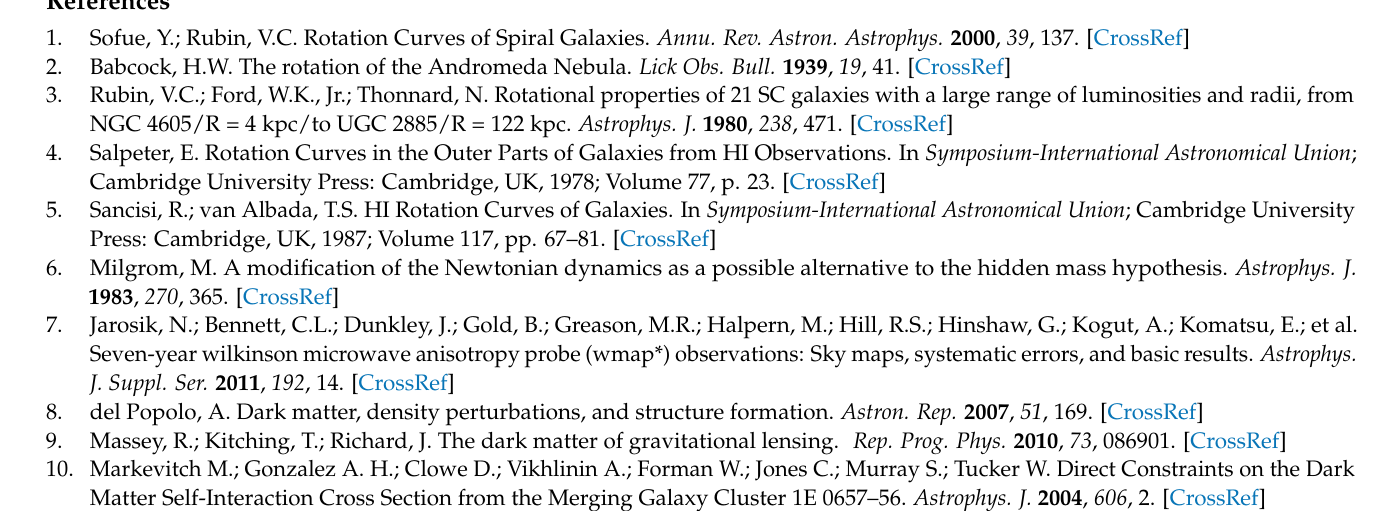
Figure A3. RCs for the different galaxies are presented. In each panel one can see the measured values (black error bars) together with the predicted curve (red line). The dashed blue curve corresponds to the Newtonian term v k ( r ) while the dashed green line corresponds to the linear correction term ω r